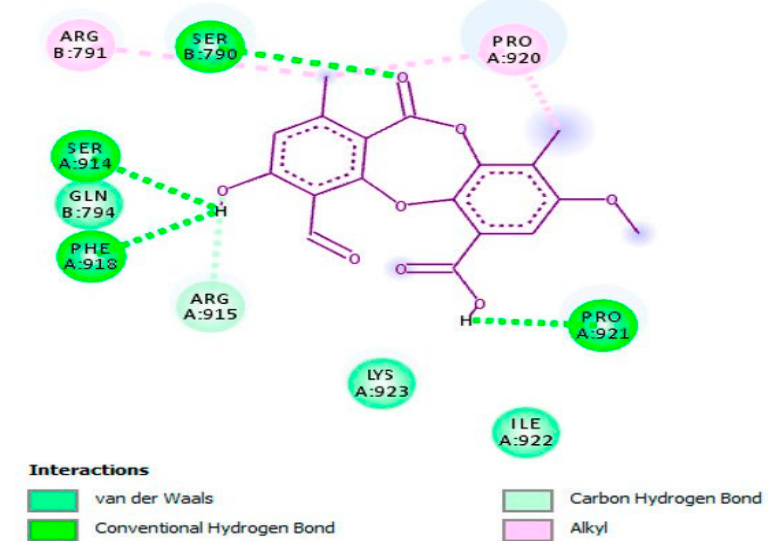
Figure 7. Molecular interaction of psoromic acid (PA, 45 ) with the active site of HSV-1 DNA polymerase. Amino acid residues involved in HSV-1 DNA polymerase stabilization along with the hydrogen bonding and other essential interactions for enzyme inactivation are presented. The key functional groups of PA that are responsible for anti-HSV-1 DNA polymerase activity are depicted. This figure and its description have been adapted from Hassan et al. [46] with permission, as the article has 4.0 license.